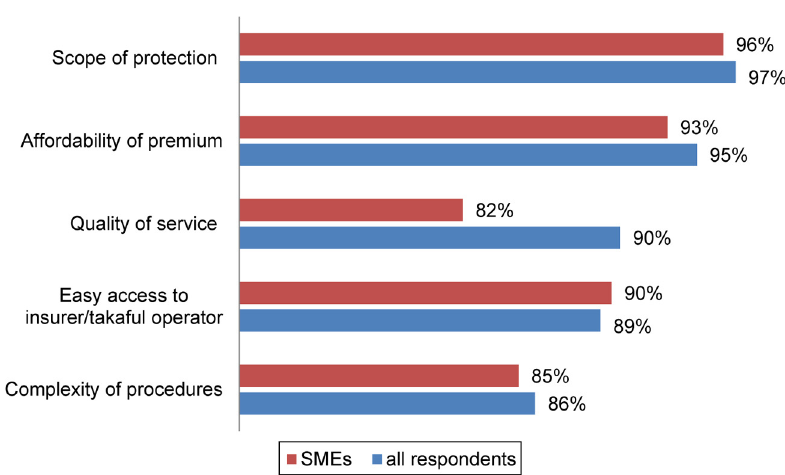
Figure 20. Factors considered